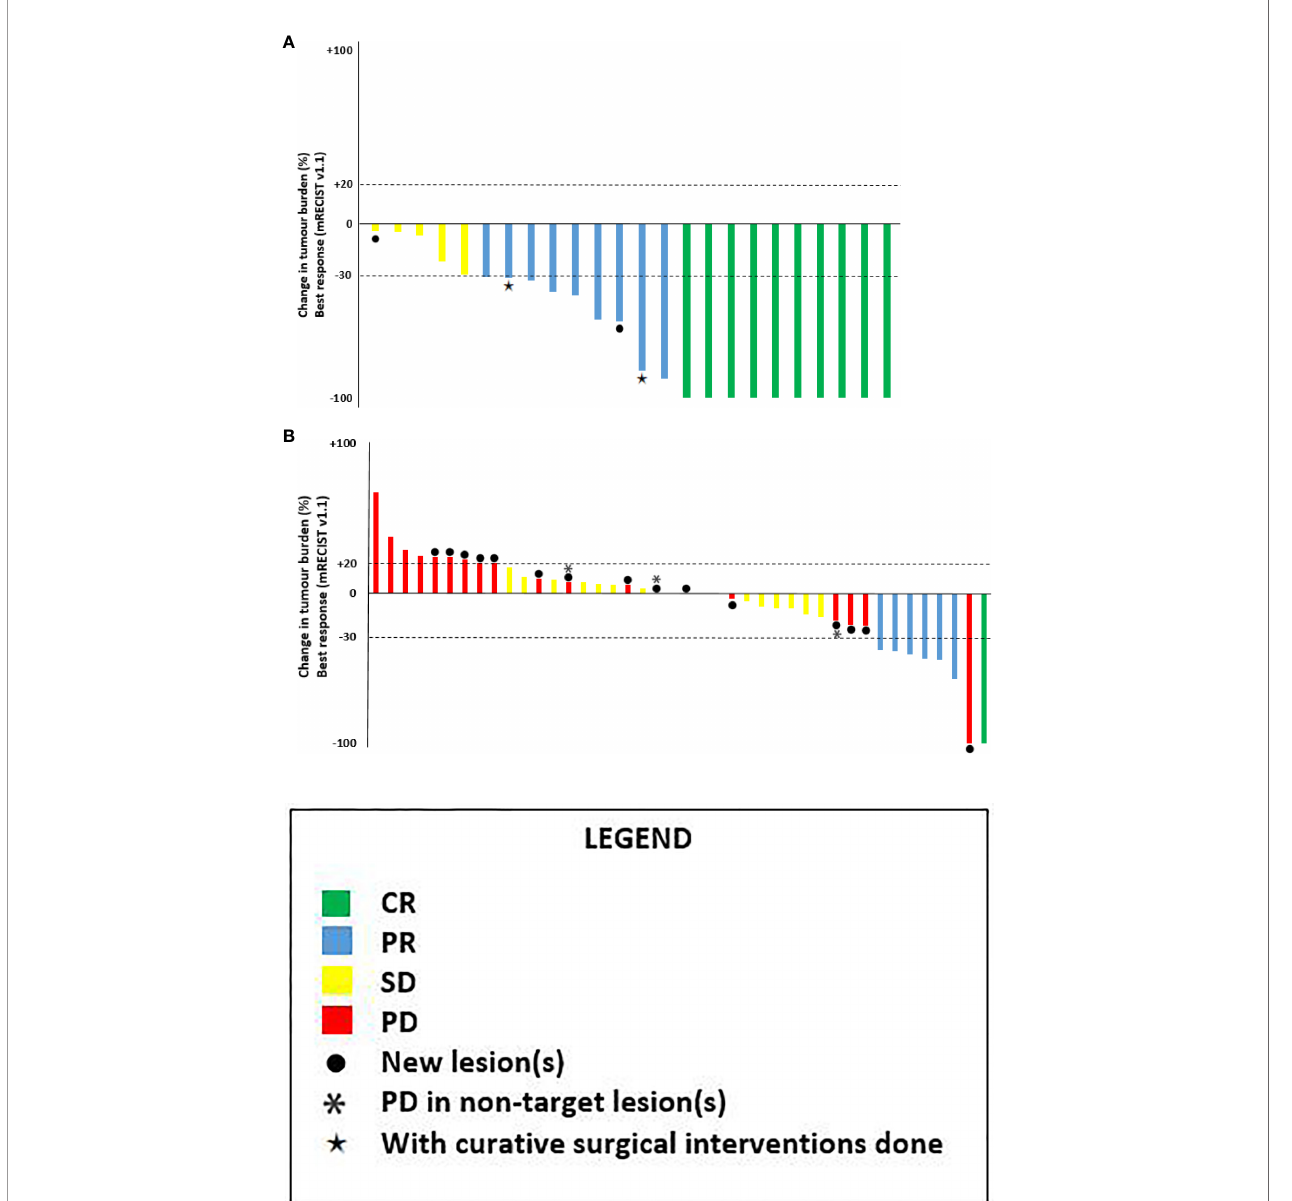
FIGURE 3 | Waterfall plots of best overall response of the target lesion(s) as per mRECIST v1.1. (A) SBRT-IO arm: 16 patients with total 24 lesions*. (B) Matched- TACE arm: 42 lesions in 48 matched patients (6 of them didn ’ t have tumour reassessment). CR, complete response; PR, partial responses; SD, stable disease; PD, progressive disease. ● : patients exhibiting new lesions at subsequent evaluation, *: progression in non-target lesions, ★ : patients with curative surgical interventions done after responding to initial